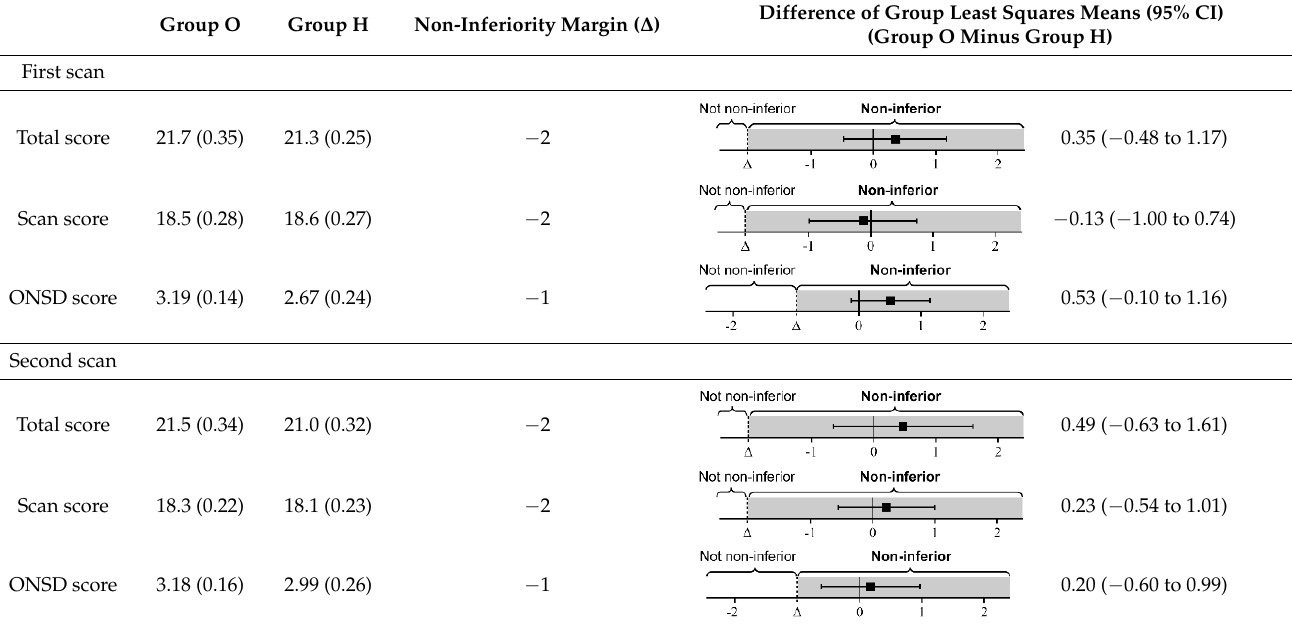
Table 2. The non-inferiority analysis of ocular POCUS scan between groups.